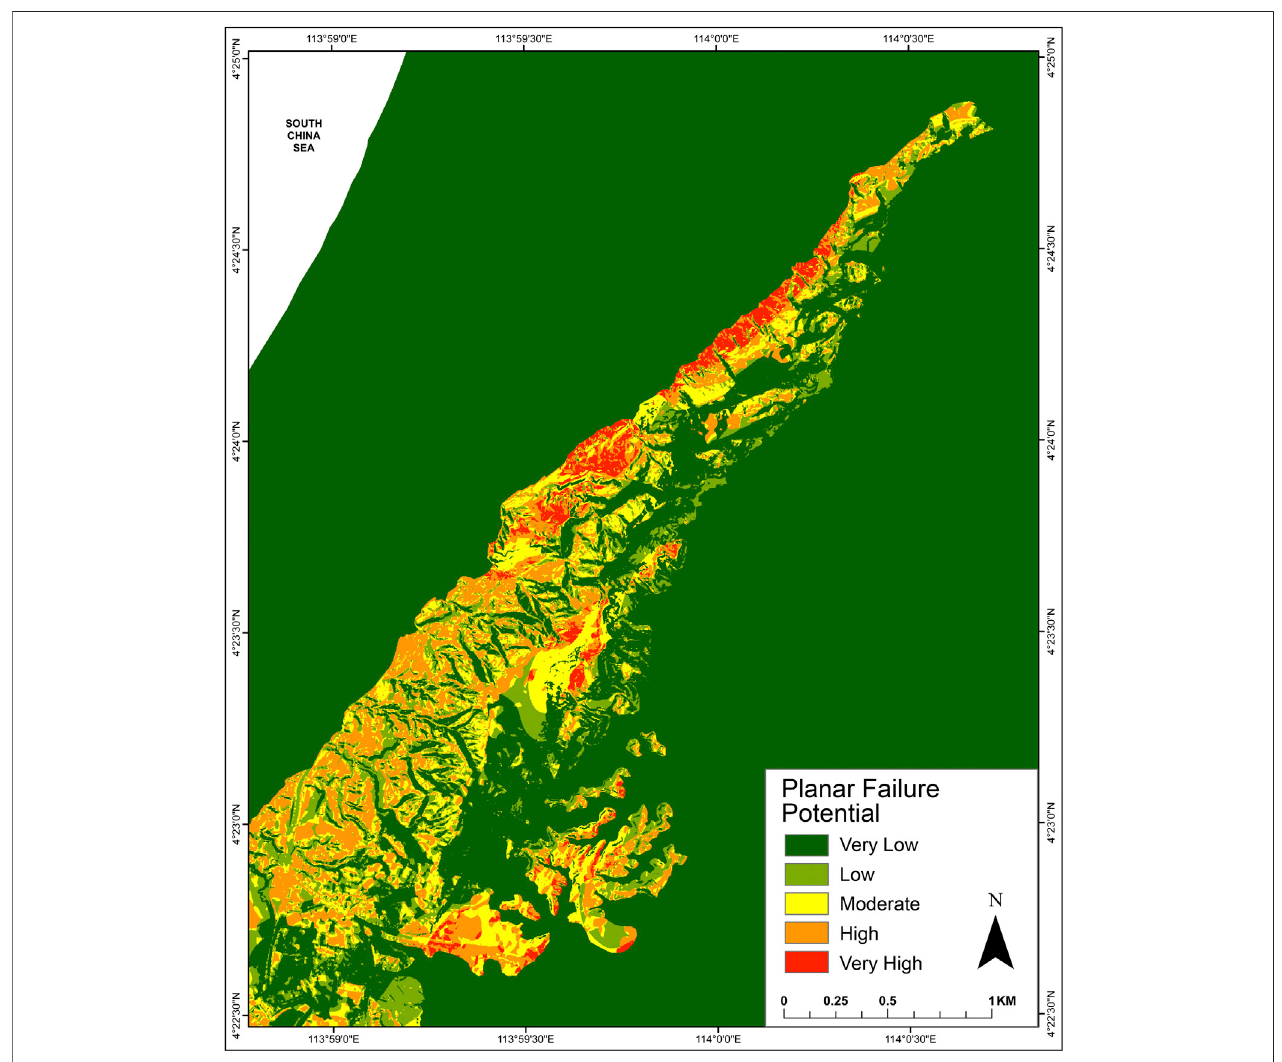
FIGURE 6 | Planar failure potential map of Canada